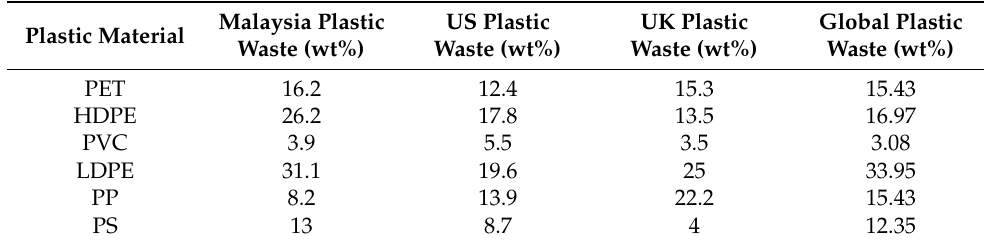
Table 1. Global composition of plastic waste in municipal solid waste. Reprinted with permission from ref. [23]. Copyright © 2022